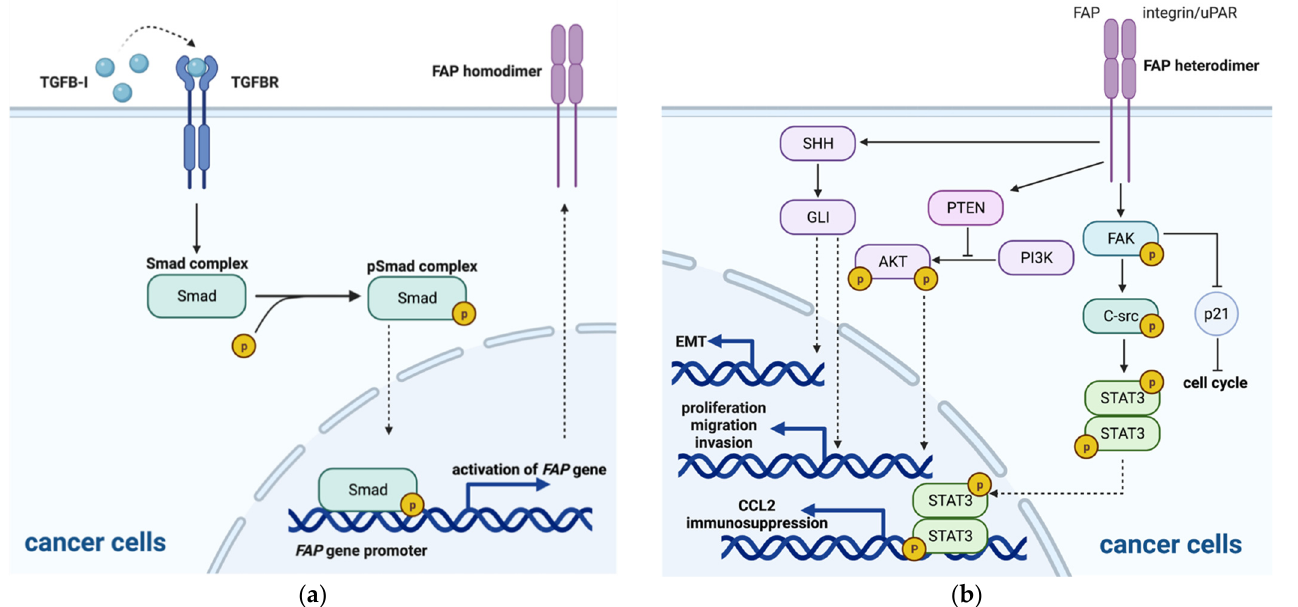
Figure 1. The signaling pathway in FAP regulation. ( a ) Regulation of FAP expression via the TGF β signaling pathway in GBM cells; ( b ) downstream signaling pathway regulated by activated FAP heterodimers leading to various effects on cancer cells, including proliferation and invasion, immunosuppression and epithelial-mesenchymal transition (EMT).